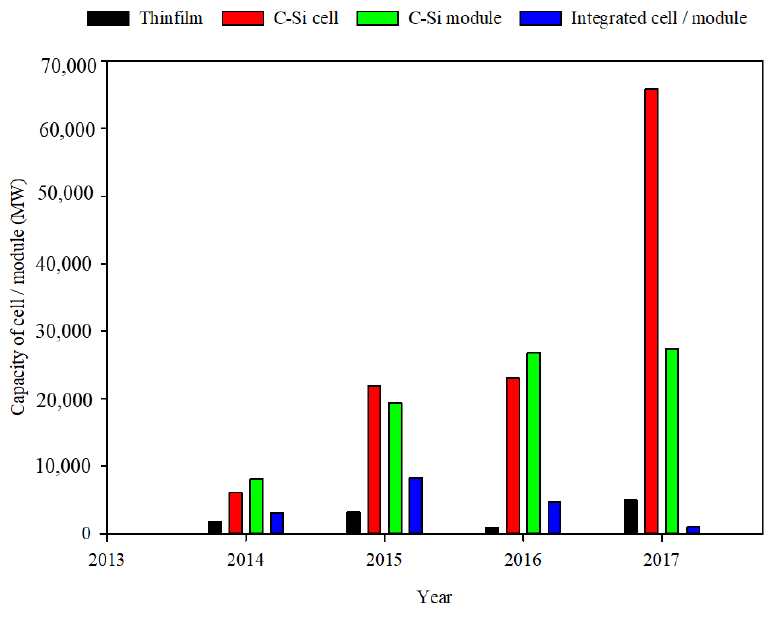
Figure 5. The cell/module capacity from 2014 to 2017